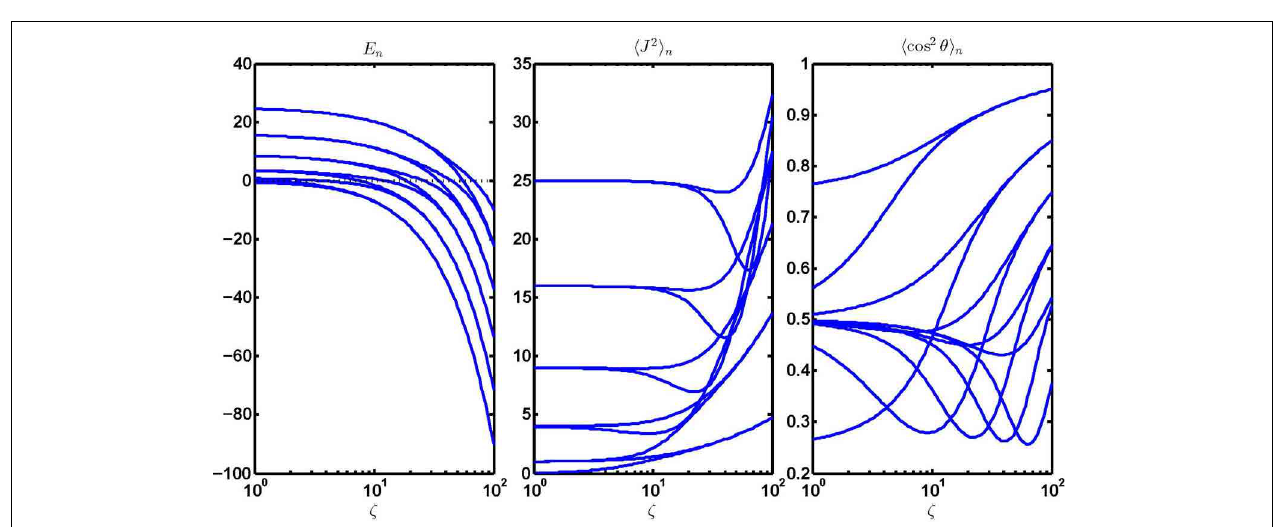
expectation values of the squared angular momentum (cid:9) J 2 (cid:10) and alignment cosine (cid:9) cos 2 θ (cid:10) . Note that the orientation cosine vanishes